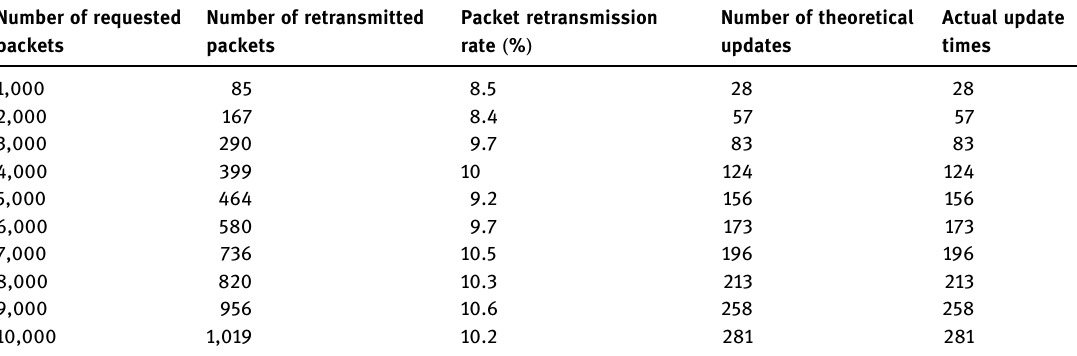
Table 4: Key update synchronization between master and slave devices